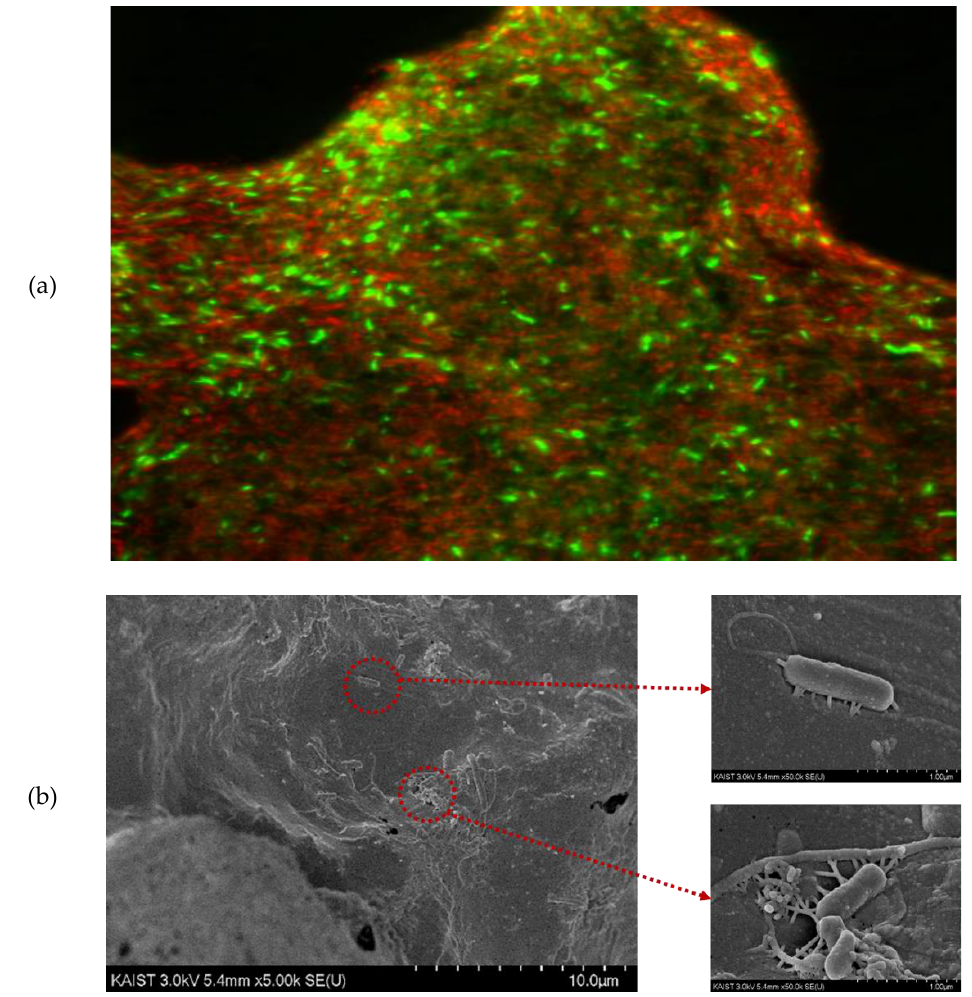
Figure 5. ( a ) The confocal laser scanning microscopy (CLSM) and ( b ) scanning electron microscopy (SEM)images of biofilm attached to the surface of CHM taken from R1 at the end of opera- tion.